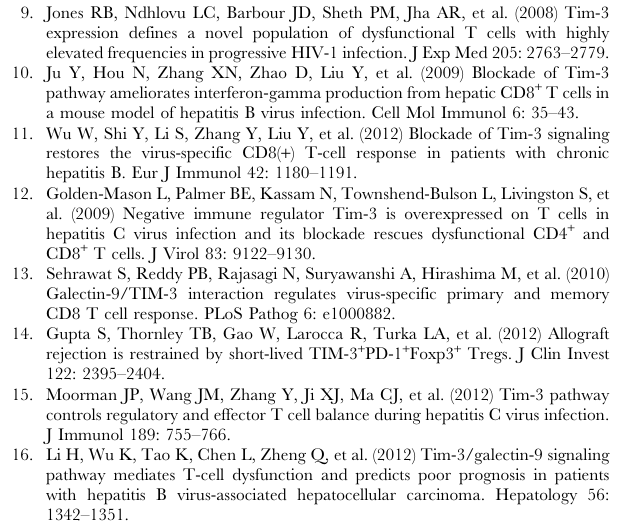
Figure S2 Proportion of Tim-3 + lymphocyte subsets in Tim-3 + cells. Frequency of T cells (CD3 + ), CD4 T cells cytes isolated from PBMCs from normal controls (NC), PBMCs from HCC patients (HCC), nontumor-infiltrating lymphocytes (NIL) and tumor-infiltrating lymphocytes (TILs). At least 12 samples were tested in each group. Bars indicate the SEM. *, Figure S3 Tim-3 is upregulated on tumor-infiltrating Foxp3 + CD4 T cells isolated from colon carcinoma, cervical cancer and ovarian cancer patients. A. Proportion of Tim-3 + CD4 T cells isolated from paired non-tumor-infiltrating lymphocytes (NILs) and tumor-infiltrating lymphocytes (TILs). Each line represents a single case; *, P , 0.05. B. Representative FACS analysis of Tim-3 and Foxp3 expression in NILs and TILs isolated from patients with colon carcinoma ( n = 4), cervical cancer ( n = 3) and ovarian cancer ( n = 3). Figure S4 Proportion of Th2, Th17, Th1 and Treg cells in Tim-3 2 and Tim-3 + CD4 T cells. Statistical analysis showed the percentage of IL-4 + , IL-17 + , IFN- c + , IL-2 + and Foxp3 + cells in Tim-3 2 and Tim-3 + CD4 T cells from non-tumor- infiltrating lymphocytes (NIL) and tumor-infiltrating lymphocytes (TIL) isolated from HCC patients. At least 6 samples were tested Figure S5 Statistical analysis showed the mean per- centage of CD25 + cells (A) and CD127 low cells (B) in the Tim-3 positive or Tim-3 negative CD4 T cell subsets (left), and the proportion of Tim-3 + cells in the CD25 (A) and CD127 (B) high or negative/low CD4 T cell subsets (right) isolated from HCC patients. At least 12 samples were tested in each group. Bars indicate the SEM. *, P , 0.05;